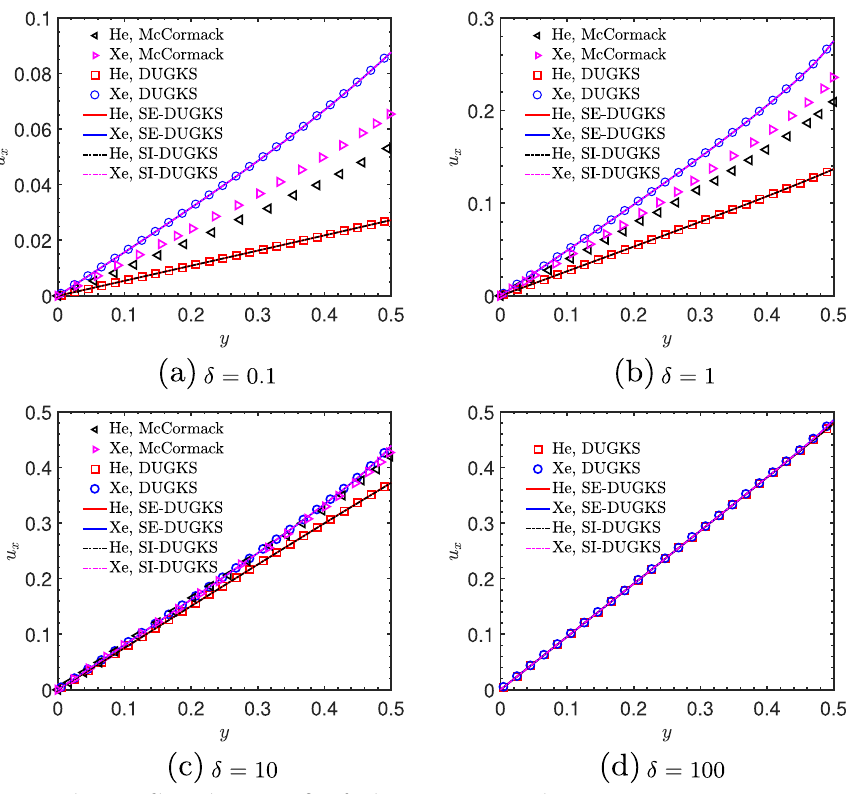
Fig. 13 Velocity profiles in the Couette flow for the He-Xe mixture with C 0 = 0.5